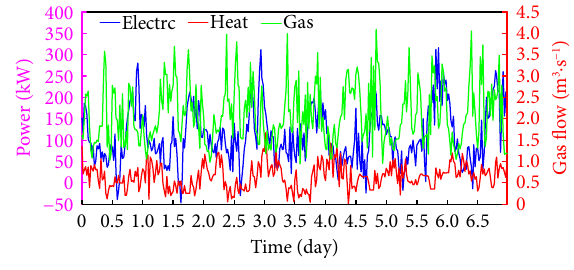
Fig. 14 Generated output of the IES.